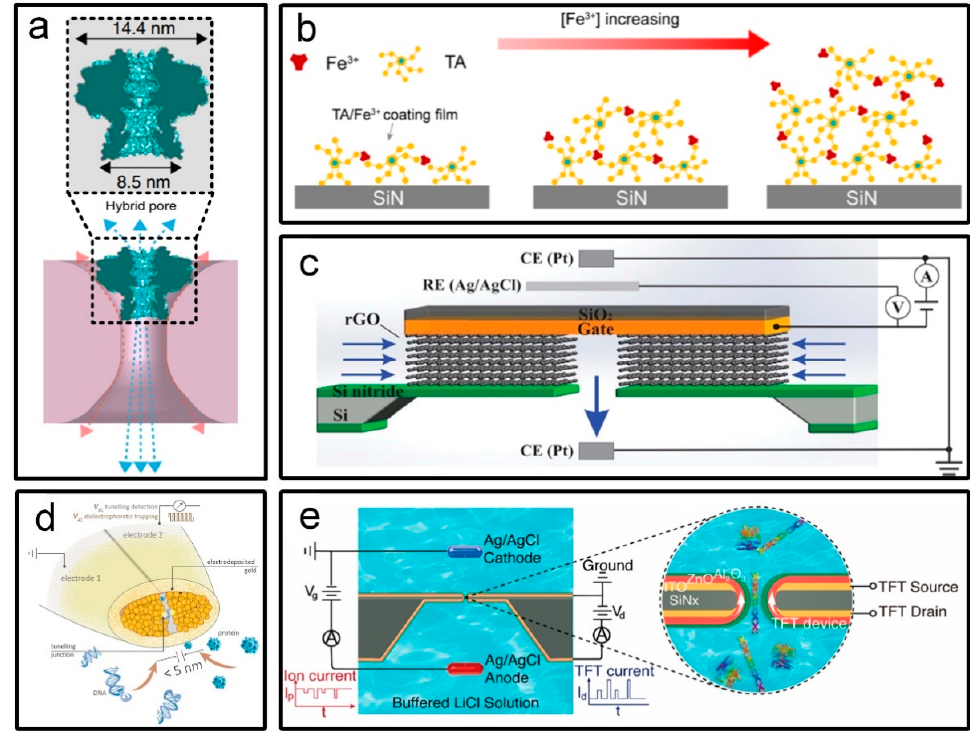
Figure 7. Recent solutions for small-size nanopore fabrication. ( a ) Cartoon image of the hybrid nanopore [104]. ( b ) Schematic diagram describing that the thickness of the coated TA/Fe 3+ mem- brane is controlled by the concentration of the Fe 3+ [105]. ( c ) Schematic of our atomic-scale graphene channel device with electric potential control using a three electrode configuration [106]. ( d ) Con- ceptual design of the quantum mechanical tunnelling probe [107]. ( e ) Schematic of a thin-film transistor − nanopore device and translocation experiment setup that concurrently measure both ionic and thin-film transistors signals